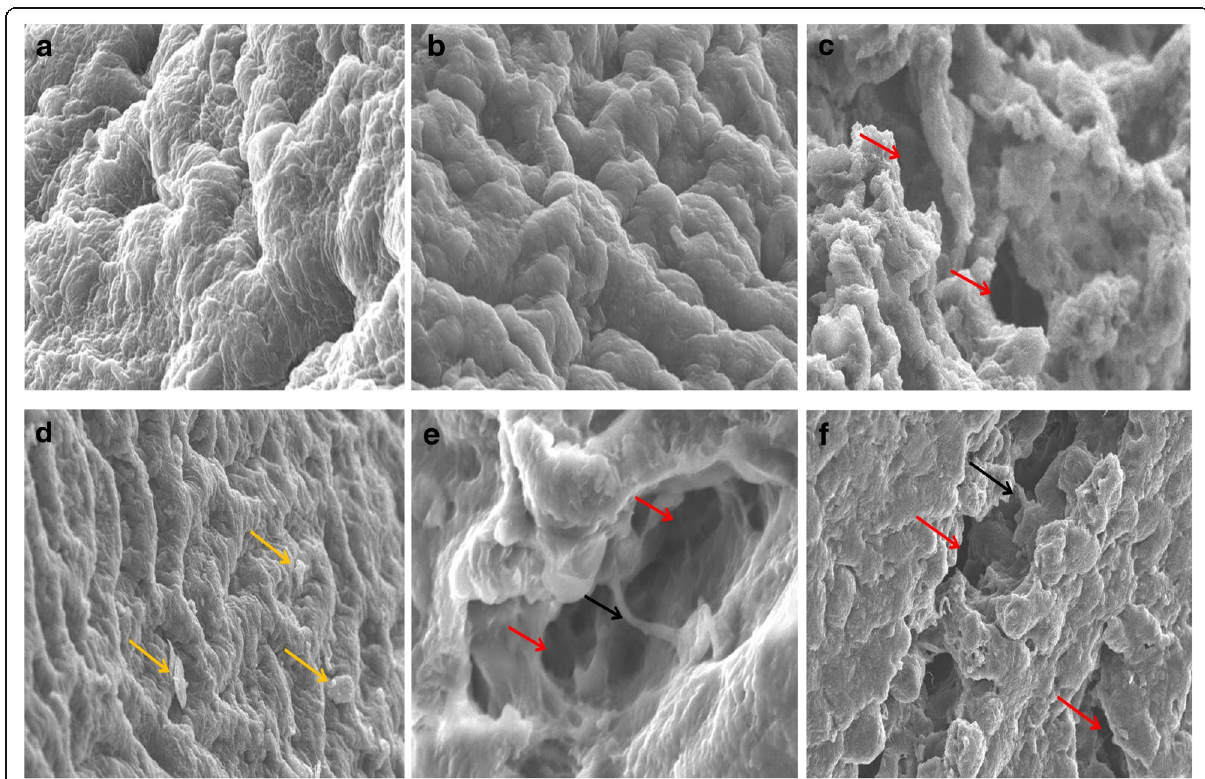
Fig. 4 Scanning electromicrograph in renal tissue showing a control group with normal ultrastructure (×1500), b CS-treated group without deviation from control group (×1300), c Li-treated group with obvious lesions represented by deep irregular cracking with cellular bridging (×1300), d CS pre-treated group without alterations or deviation from control group (×1000), e CS simultaneous-treated group with severe ultrastructural alterations represented by deep irregular cracking with cellular bridging (×1700), and f CS post-treated group with ultrastructural variations represented by irregular cracking with cellular bridging in addition to cellular lose